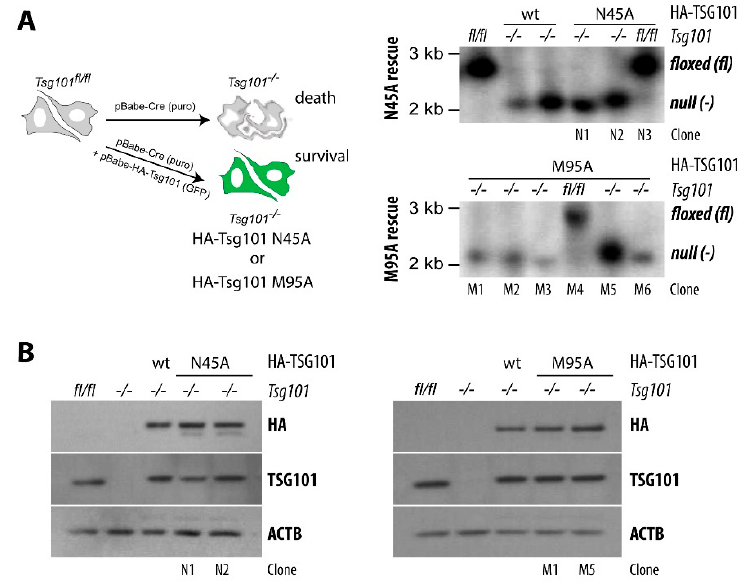
Figure 3. Exogenous wildtype TSG101 and mutants with impaired ubiquitin (N45A) or PTAP (M95A) binding restore growth and survival of mouse fibroblasts that lack both endogenous Tsg101 alleles. ( A ) Experimental design of genetic rescue experiments in mouse TSG101 conditional knockout cells (left panel) to generate clones that exclusively express HA-tagged, exogenous wildtype or N45A and M95A mutants of TSG101. The right panel shows Southern blot results to verify the complete deletion of both endogenous Tsg101 alleles in individual rescue clones. ( B ) Western blot analyses to determine the expression of exogenous, HA-tagged TSG101 (wt, wildtype; N45A and M95A mutants) in selected rescue clones in comparison to the parental cells expressing endogenous TSG101 ( Tsg101 fl/fl ). Detailed methods for the genetic rescue experiment, Southern blot strategy, and immunoblot reagents and methodologies can be found in our earlier publications [15,38,57].